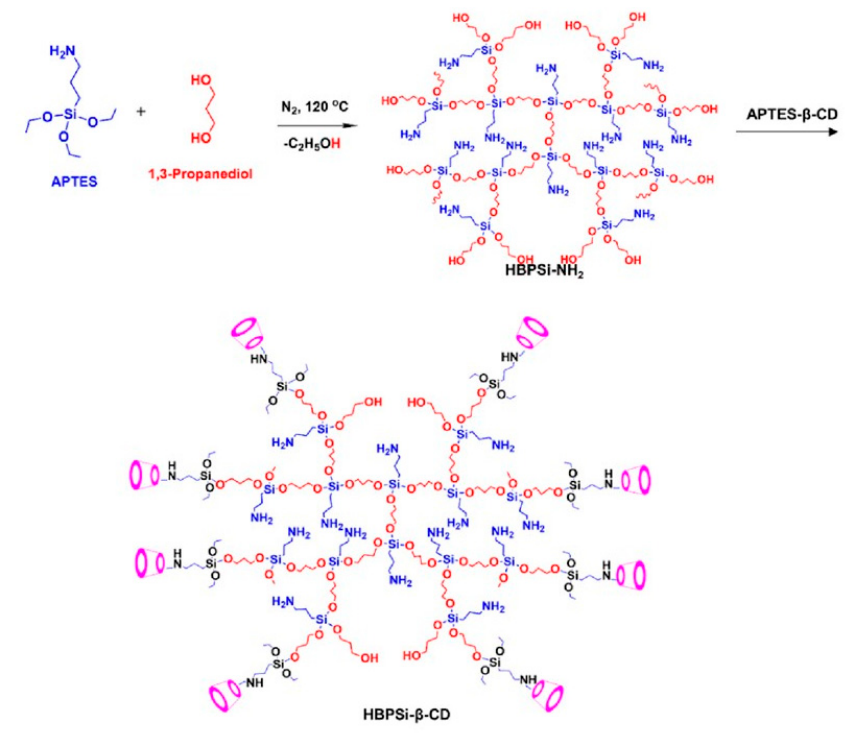
Figure 9. Synthesis route of HBPSi- β -CD [59] . Copyright 2022, American Chemical Society.